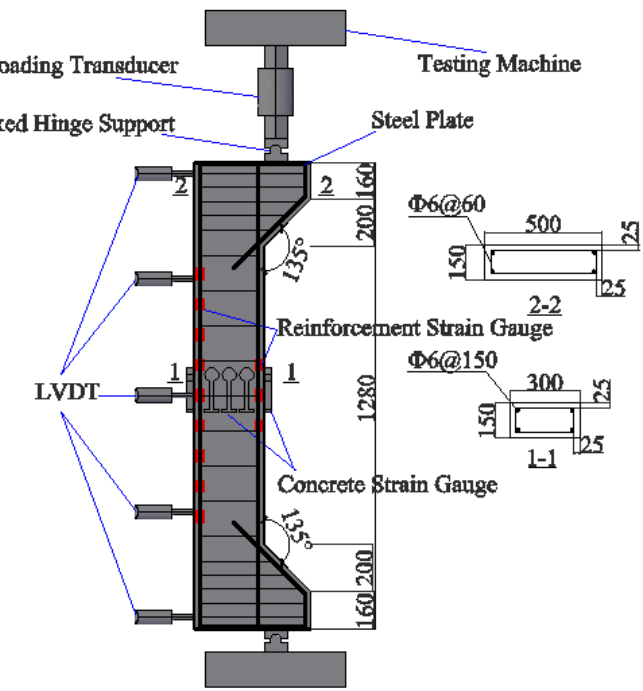
Figure 4. The details of the specimens and the layout of the measurements.